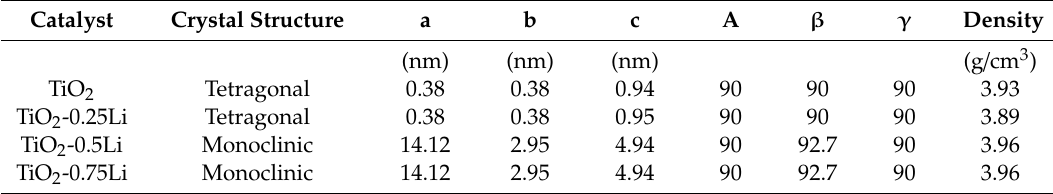
Figure 1. XRD pattern of unmodified TiO 2 and lithium-impregnated TiO 2. Table 1. The crystallographic parameters of synthesized catalysts.